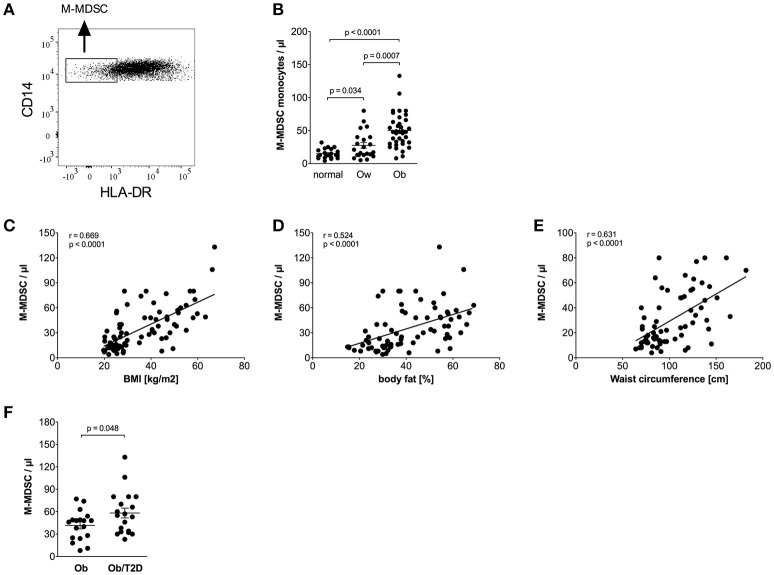
Quantification of M-MDSCs of normal, overweight, and obese individuals. (A) Representative dot plot of CD14 and HLA-DR expression on monocytes. (B) Absolute numbers of M-MDSCs of normal (n = 21), overweight (ow, n = 22), and obese (ob, n = 37) individuals. Scatter plots show mean ± SEM. (C–E) Correlation of M-MDSC numbers with BMI (C, n = 80), body fat (D, n = 75), and waist circumference (E, n = 67). (F) Absolute numbers of M-MDSCs of obese individuals with (n = 19) and without (n = 18) impaired glucose tolerance. Scatter plots show mean ± SEM.